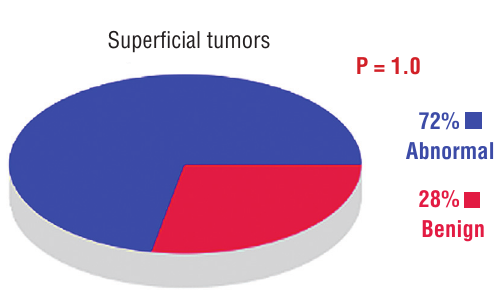
Figure 2 - UTC and tumor stage.